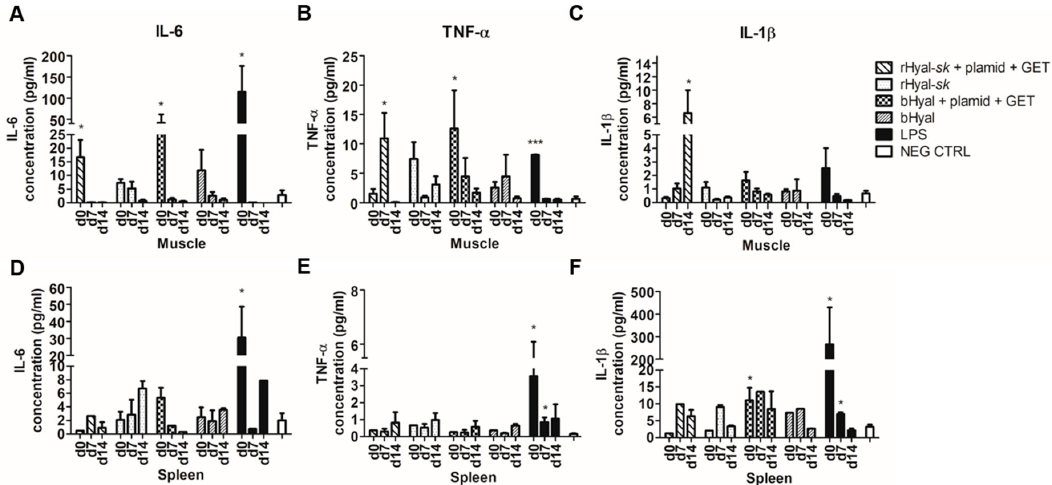
Figure 5. Measurement of IL-6, IL-1 β and TNF- α levels in skeletal muscle and spleen of mice treated with rHyal- sk in the presence and absence of GET. Comparison of cytokines levels measured by